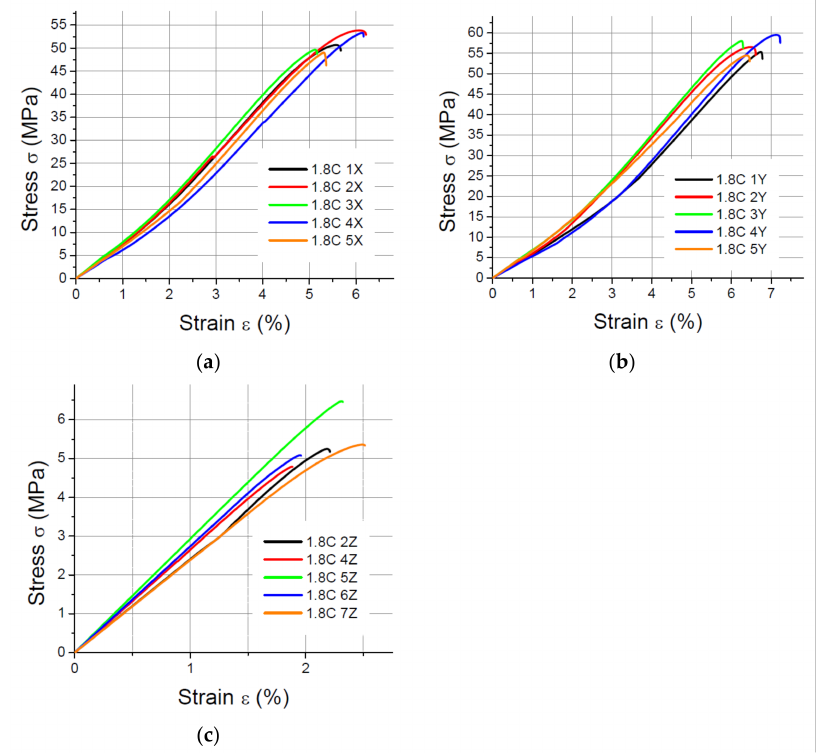
Figure 10. Tensile test results for 1.8 mm thick specimens made of PLA-CF printed in ( a ) the X orientation; ( b ) the Y orientation; ( c ) the Z orientation.